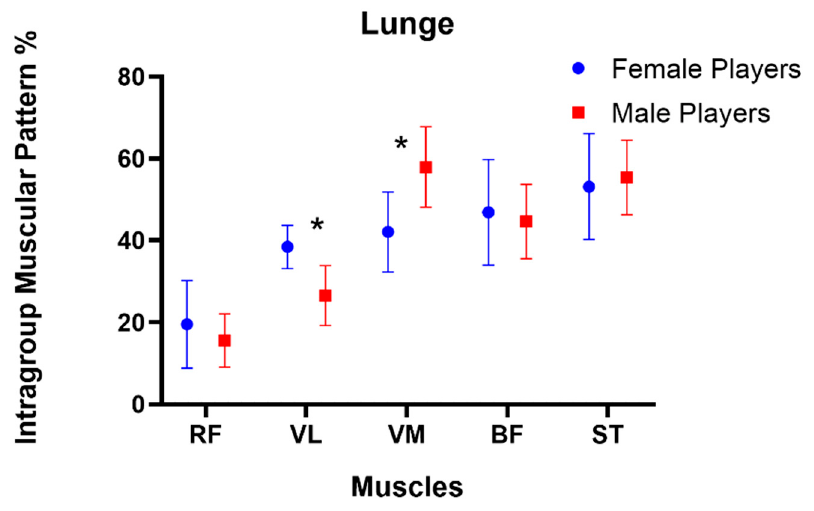
Figure 2. Intragroup muscular pattern (mean ± SD) in percentage. The intragroup muscular pattern expresses the activation of each muscle belly in relation to the total muscle (quadriceps and hamstrings). The asterisk (*) shows that there is a significant difference. Table 3. Intragroup muscular pattern in percentage.